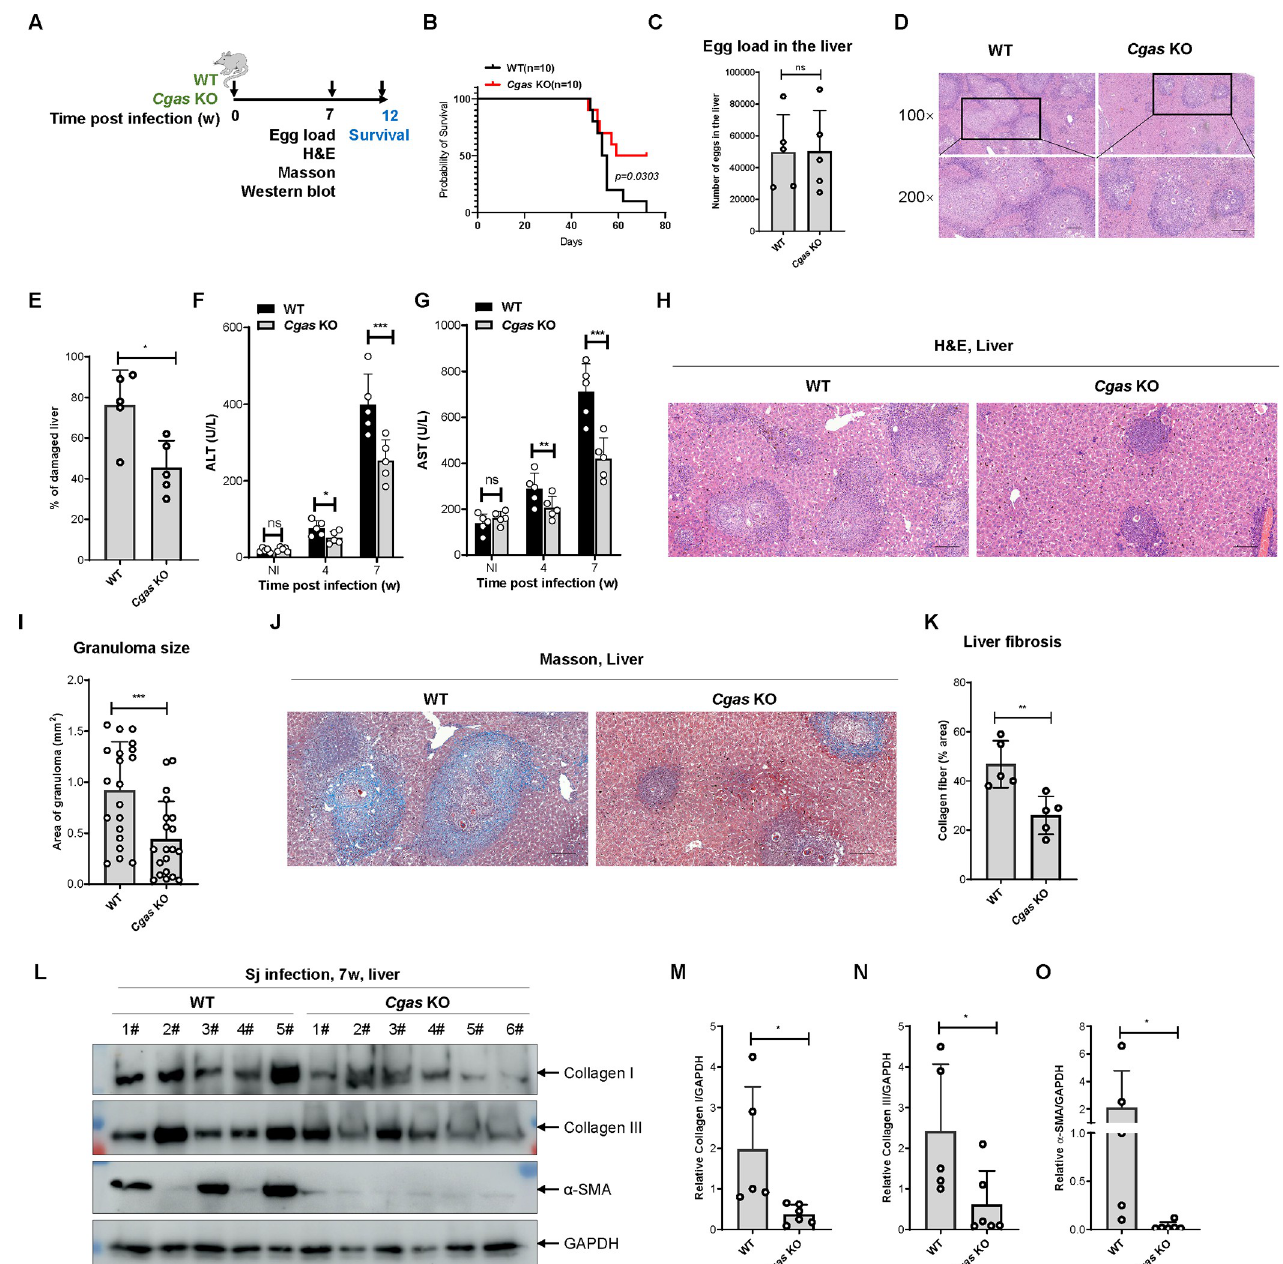
Fig 1. cGAS exacerbates Schistosoma japonicum infection in mice. (A) Scheme for monitoring of the survival of mice infected with S . japonicum . (B) The survival curve of mice infected with S . japonicum . The Kaplan–Meier method was used for the statistical analysis. (C) The egg loads in the livers of wild-type and Cgas knockout mice infected with S . japonicum . Data are expressed as the mean ± SD of the indicated number of mice from one of three independent experiments. (D-E) Representative imaging showing liver damage in the wild-type and Cgas knockout mice infected with S . japonicum . The quantification of the liver damage is shown in E. Data are expressed as the mean ± SD of the indicated number of mice from one of three independent experiments. (F-G) Measurement of the level of ALT (F) and AST in the sera of wild-type and Cgas knockout mice left uninfected or infected with S . japonicum for the indicated times. Data are expressed as mean ± SD of indicated number of mice from one of three independent experiments. (H-I) Representative imaging showing egg- induced granuloma in the livers of wild-type and Cgas knockout mice infected with S . japonicum . The quantification of the area of the granuloma is shown in (I). Data are expressed as the mean ± SD of the indicated number of granulomas. (J-K) Representative imaging showing Masson staining of the fibrosis in the livers of wild-type and Cgas knockout mice infected with S , japonicum . The quantification of the area of fibrosis is shown in (K). Data are expressed as the mean ± SD of the indicated number of mice from one of three independent experiments. (L-O) Western blotting of the indicated fibrosis-related proteins in the livers of wild-type and Cgas knockout mice infected with S . japonicum . The quantification of gray intensity is shown in (M-O). An unpaired Student’s t -test was used for the statistical analysis in (C, E, I, K and M-O). Two-way ANOVA with Bonferroni’s post hoc test was used for the statistical analysis in (F and G). ns, not significant; � , p < 0.05; �� , p < 0.01; ��� , p < 0.001. Scale bar, 200 μ m.